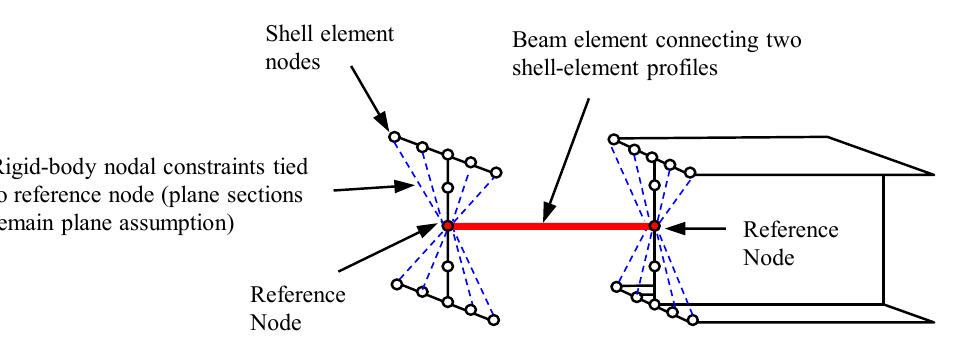
Figure 4. Shell-element to beam-element transition.